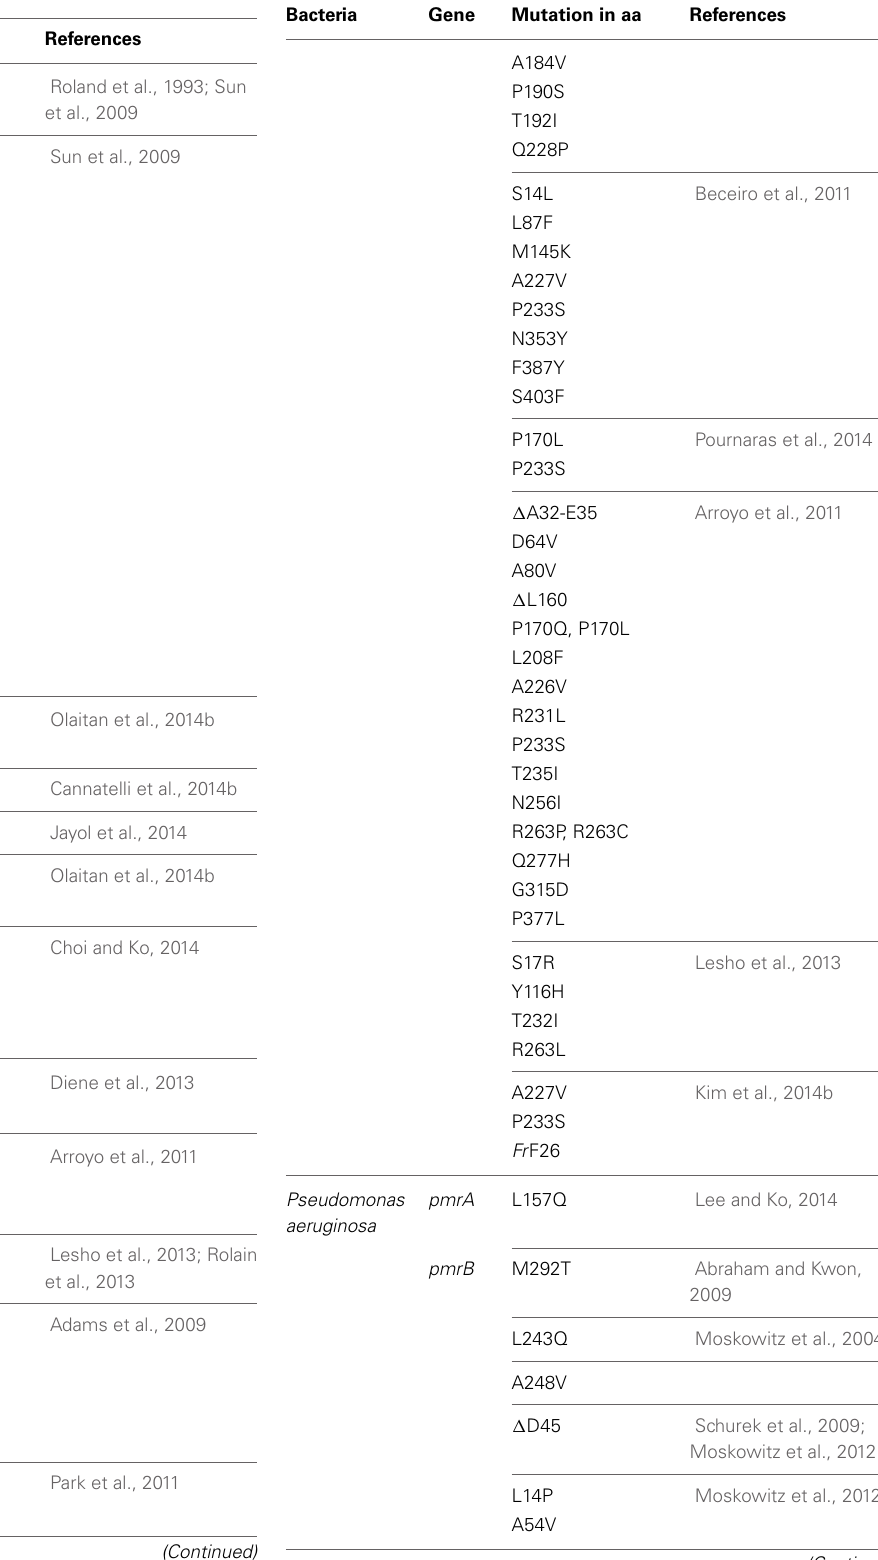
Table 1 | Mutations in two-component systems that result in their constitutive